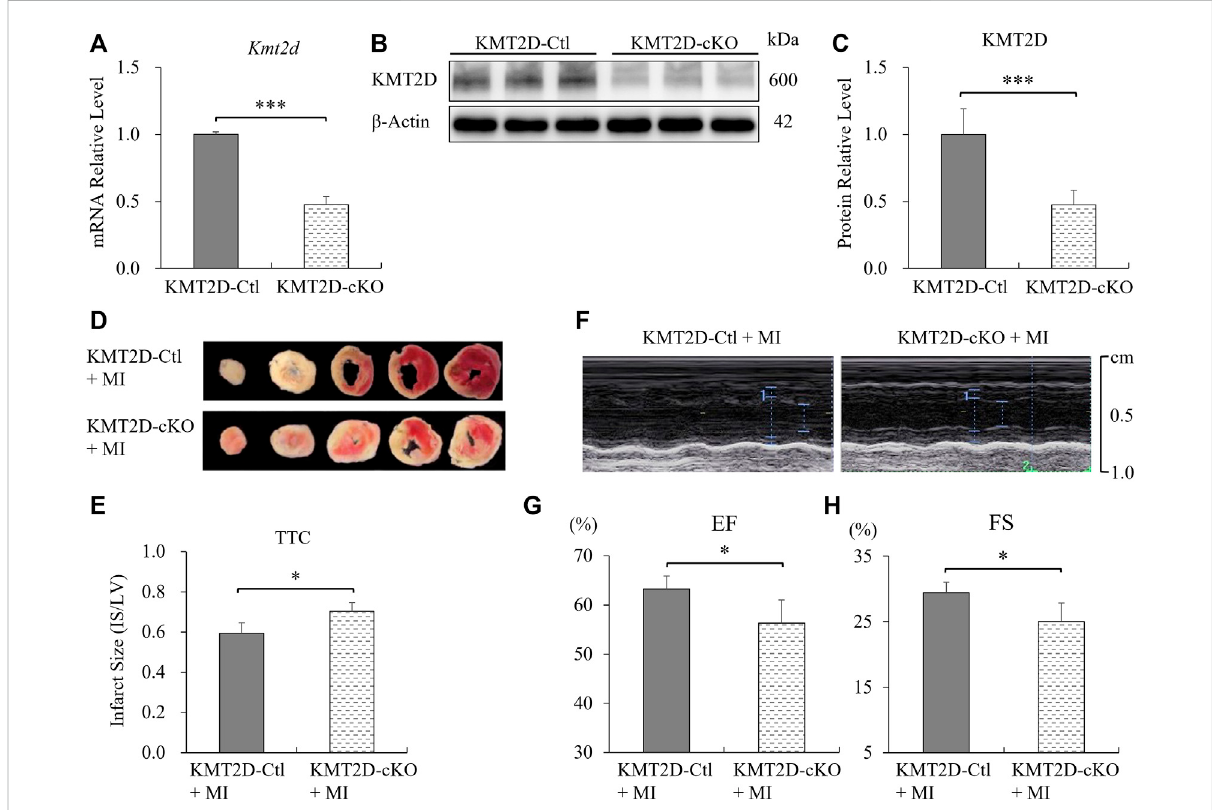
FIGURE 1 Knockout of Kmt2d aggravated ischemic injury. (A) Analysis of Kmt2d mRNA expression in the KMT2D-Ctl and KMT2D-cKO mice by qPCR. *** p < 0.001, n = 3. (B) Representative images of western blotting and (C) quanti fi cation analysis of KMT2D protein decrement of the KMT2D-cKO mice vs . KMT2D-Ctl mice. *** p < 0.001, n = 3. (D) Representative picturesoftheTTCstaining ofKMT2D-cKOand KMT2D-Ctl mice 24 hpost-MI. (E) Quanti fi cation of infarct size in the left ventricle by TTC staining. * p < 0.05, n = 5. (F) Representative images of echocardiography in two